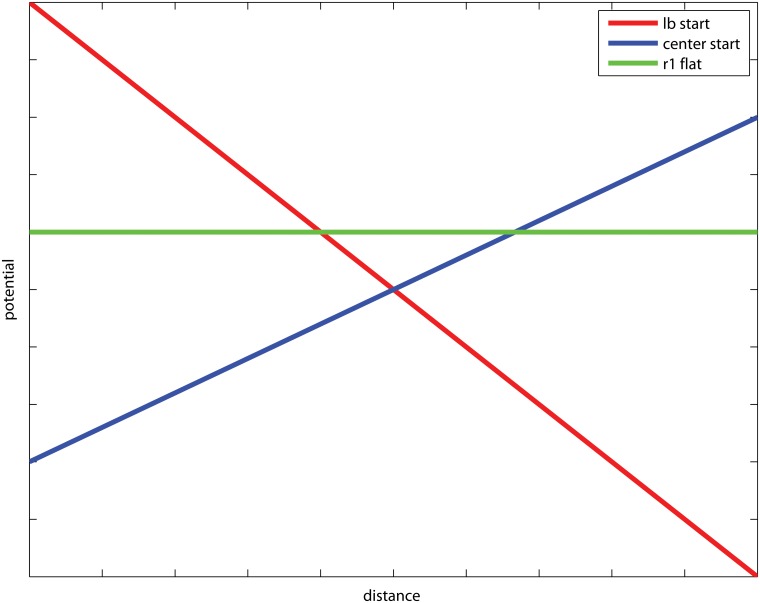
The potential functions for the example Team handball; wing change over.The potential for a lb start (red) and a center start (blue), respectively, given that r1 moves up court. For reference, the potential of the situation where r1 stays flat (green) is displayed, even though it is not a function of y.